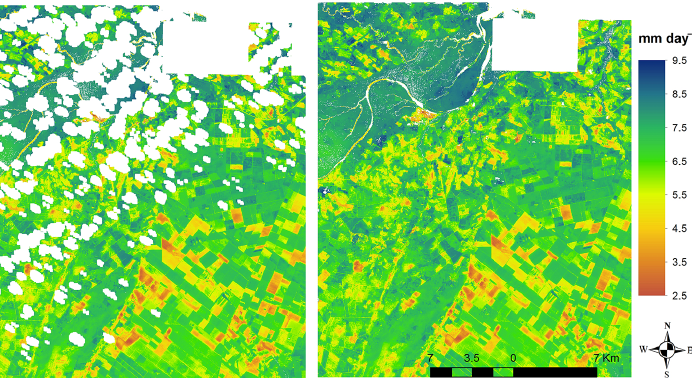
Figure 5. Example of gap-filling cloudy regions in a Landsat 8 ET image for DOY 200. The left image is Landsat-retrieved ET with clouds masked using the Fmask data layer and the right image has been processed through the Landsat gap-filling